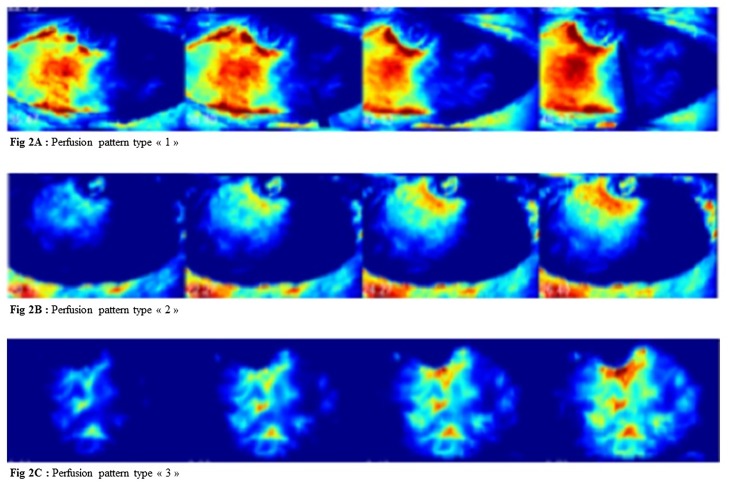
Flap perfusion patterns.Fig 2A: Perfusion pattern type «1». Fig 2B: Perfusion pattern type «2». Fig 2C: Perfusion pattern type «3». Dynamic color analysis representing fluorescence of the flap over time. Red zone is the best perfused one and blue one, the less perfused one.